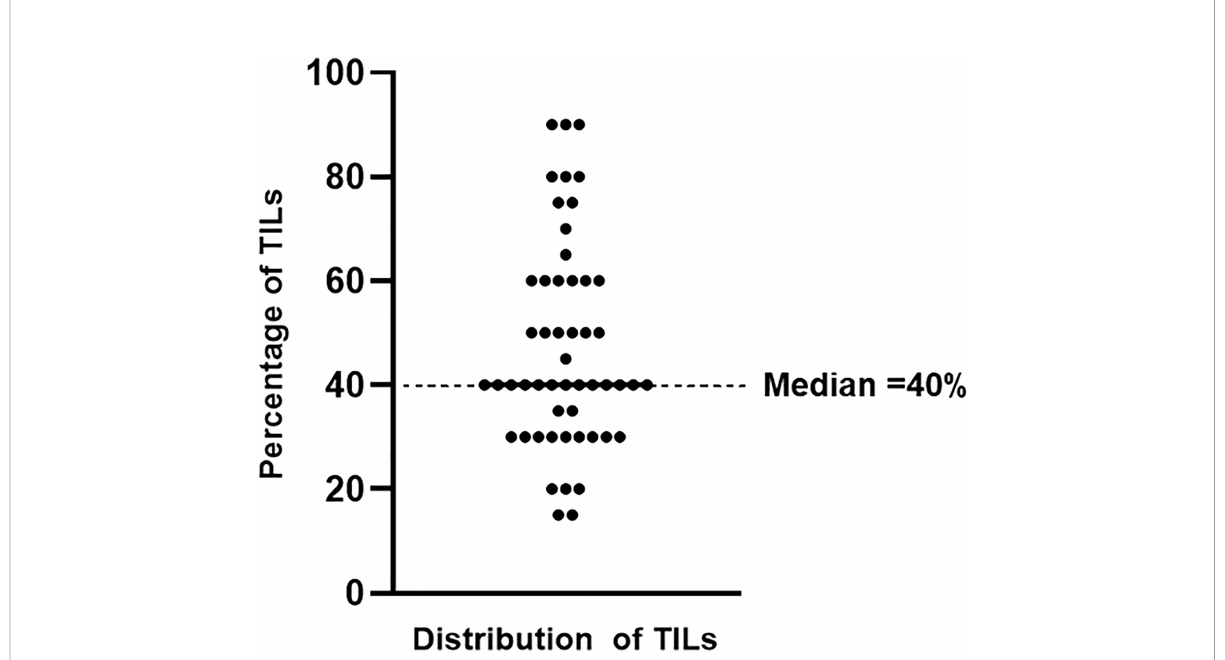
FIGURE 2 The distribution of TIL levels in distal cholangiocarcinoma. Patients with dCCA were divided in low and high TIL levels according to the median